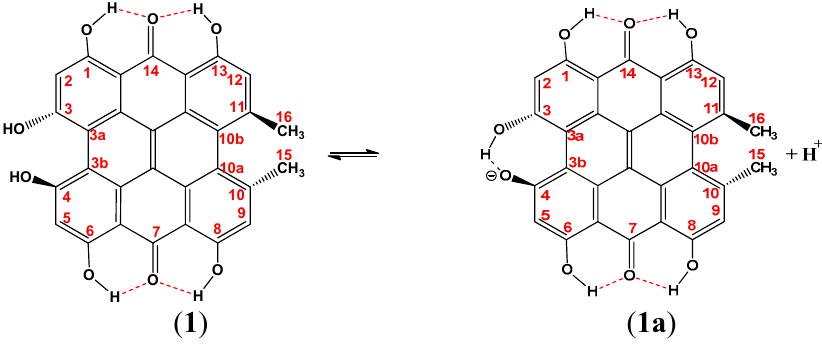
Figure 17. Solvent dependent equilibrium of the 7,14-dioxo tautomer of hypericin HyH, Q 7,14 ( 1 ), and its anionic form Hy − ( 1a ).